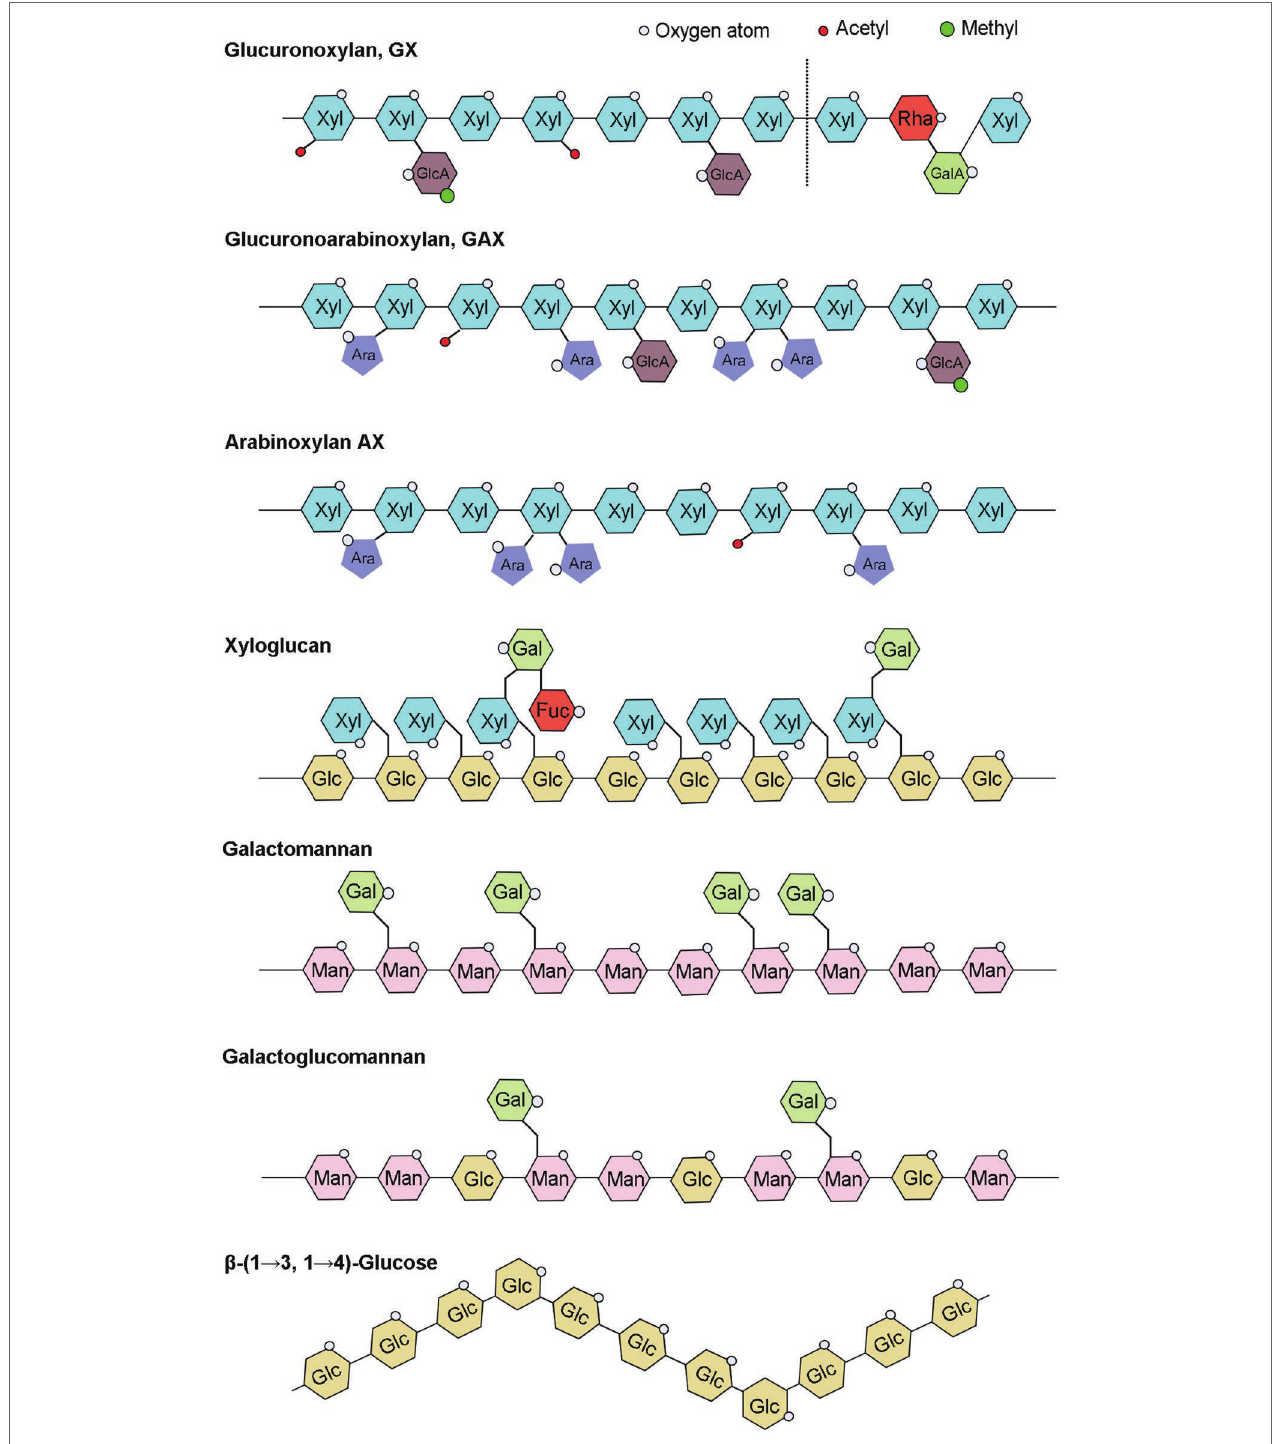
FIGURE 1 | Schematic illustration of hemicelluloses. UDP-Glc, Uridine diphosphate glucose; UDP-GlcA, UDP-glucuronic acid; UDP-Xyl, UDP-xylose; UDP-Gal, UDP- galactose; UDP-GalA, UDP-galacturonic acid; UDP-Ara, UDP-arabinose; UDP-Rha, UDP-rhamnose; GDP-Man, guanosine diphosphate-mannose; and GDP-Fuc,